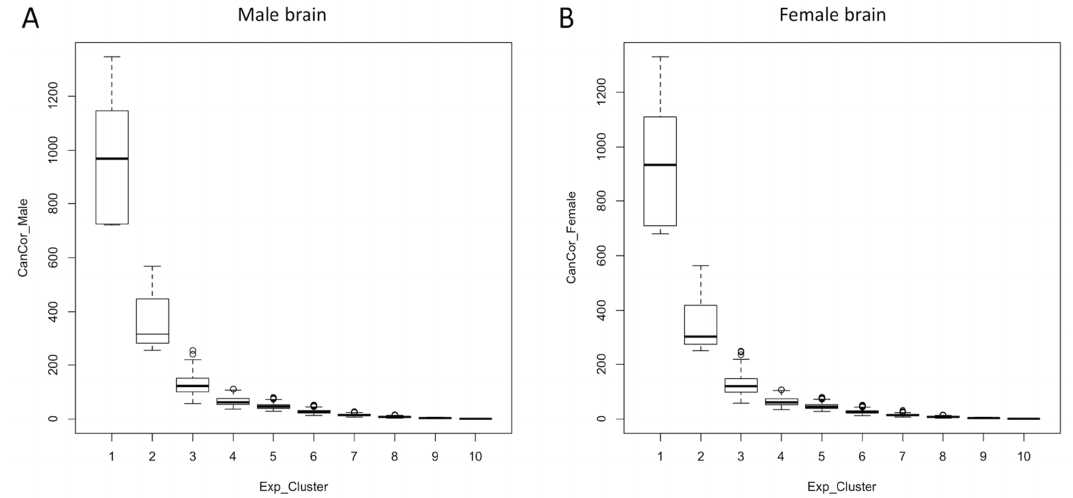
Figure 2. Box plots of covariates showing canonically correlated expression clusters between male brain ( A ) and female brain ( B ). The x-axis shows expression clusters (1–10) and y-axis shows covariates of canonical correlation. The mean value of expression cluster is shown by horizontal line inside each box. The lower and upper quartile values of covariates are shown for each cluster.